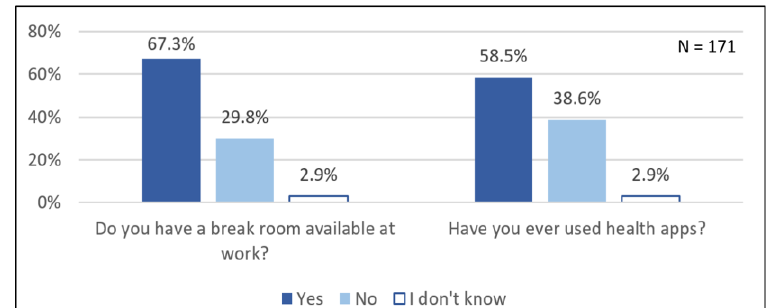
Figure 3. Potential approaches for workplace health promotion.